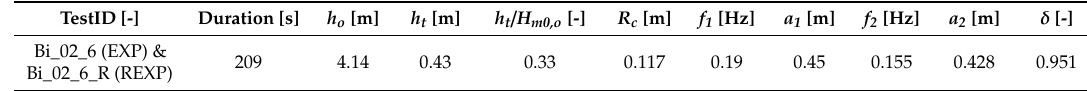
Table 1. Hydraulic parameters for the WALOWA bichromatic wave test (EXP) and its repetition (REXP): h o is the o ff shore water depth, h t the water depth at the dike toe, H m0,o the incident o ff shore significant wave height, R c the dike crest freeboard, f i the SW component frequency, a i the SW component amplitude and δ ( = a 2 / a 1 ) the modulation factor. Reproduced from the work in [3], with